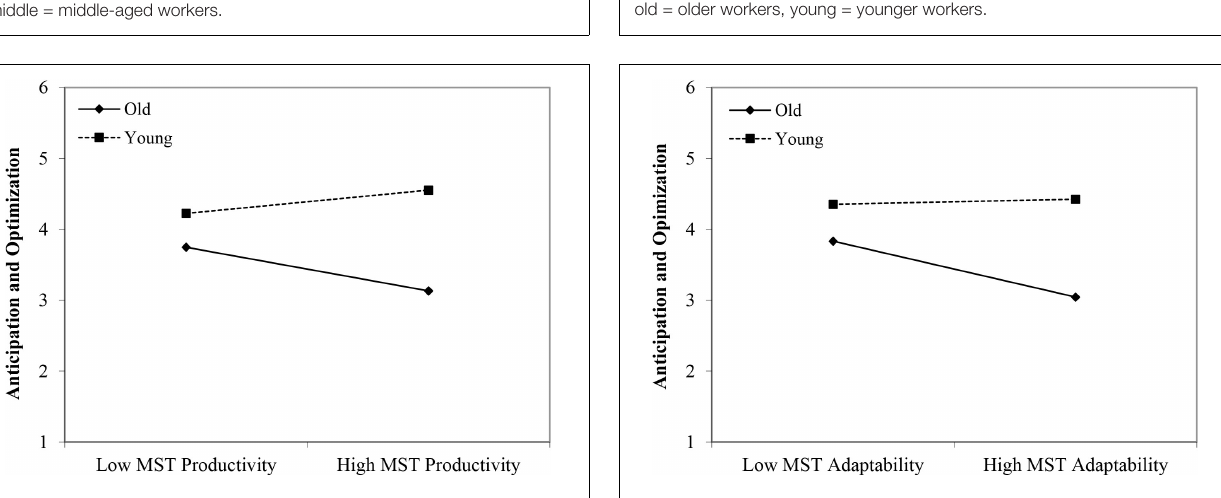
FIGURE 6 | Interaction between perceived age-based (meta-)stereotyping adaptability and age groups: Predicting anticipation and optimization. Low = –1 SD , High = + 1 SD , MST = age-based (meta-)stereotyping, old = older workers, young = younger workers.